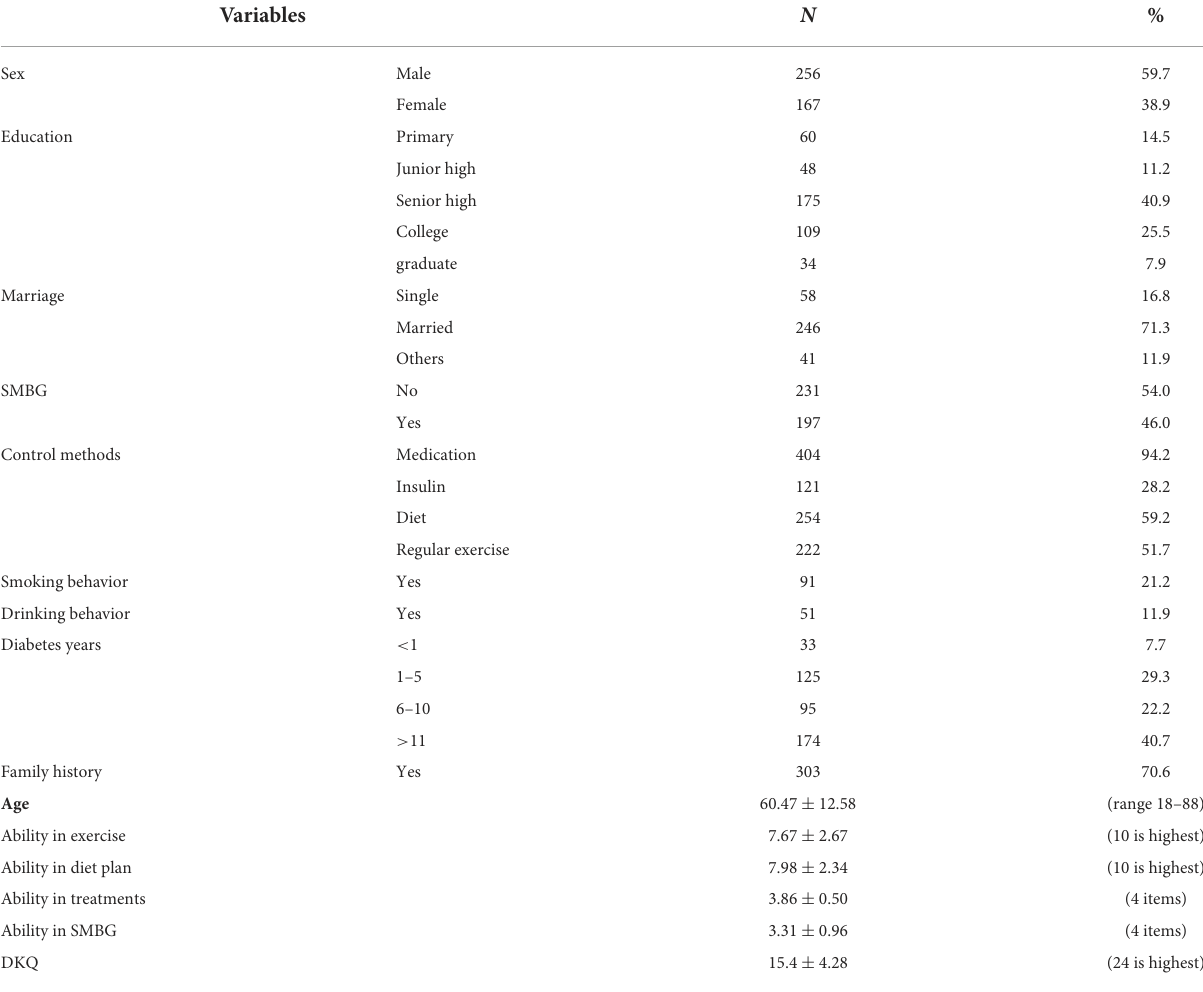
TABLE 1 The basic characteristics from the survey ( n =